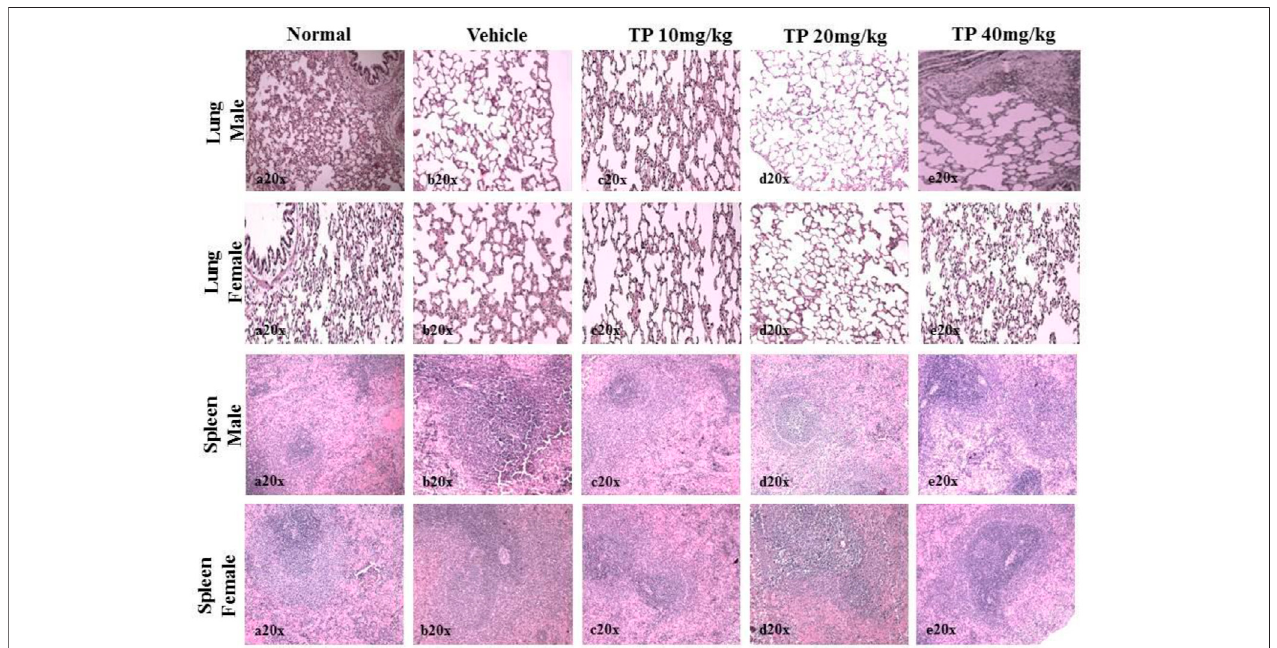
FIGURE 13 | Histopathological analysis of lung and spleen tissue showing no abnormalities in the male and female SD rats after 28-day treatment of Thamira Parpam.